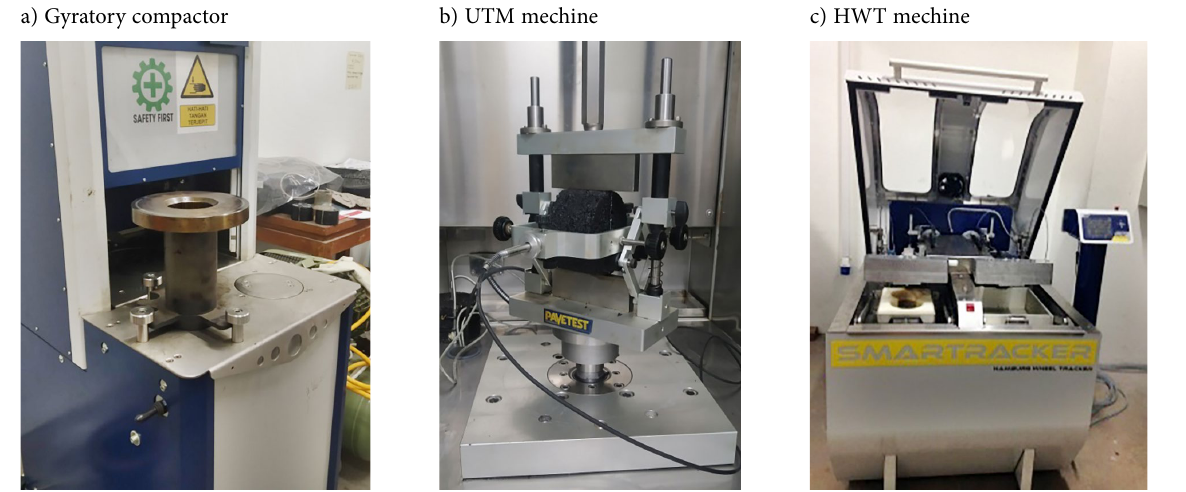
Figure 5. Gyratory compactor, UTM machine and HWT